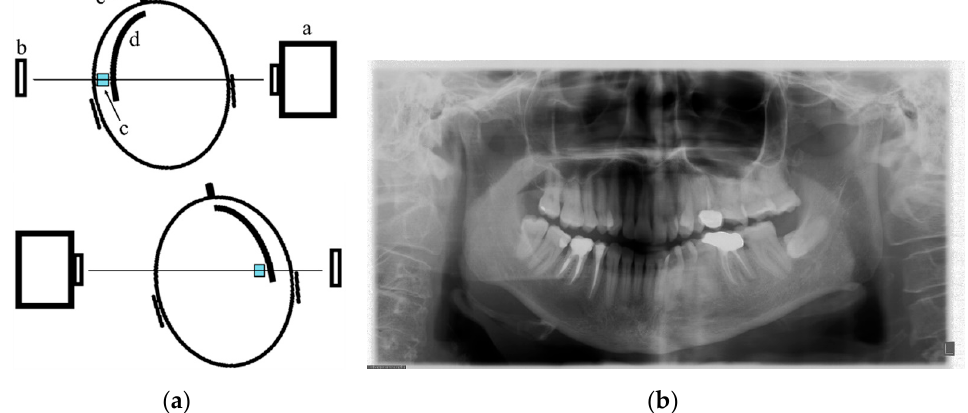
Figure 2. Rolling. Head rotation towards the left: ( a ) schematic drawing. Posterior teeth move to the right and do not coincide with the focal trough. Left hemi-arch is close to the X-ray radiation tube with consequent magnification of left hemi-arch teeth and mandibular ramus. On the contrary,